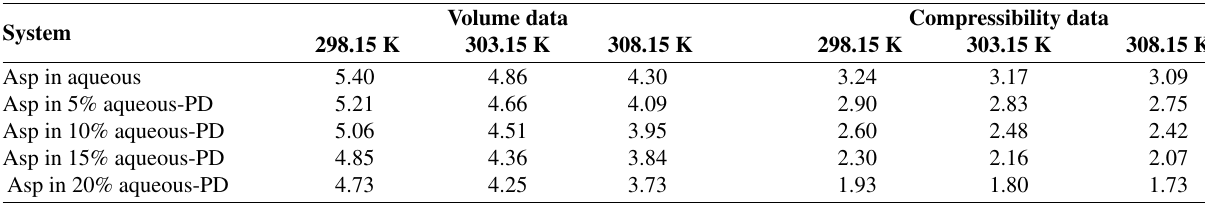
Table 10. Hydration number, n , calculated from volume and compressibility data of Asp in aqueous and aqueous solution of PD at different tem- H peratures.